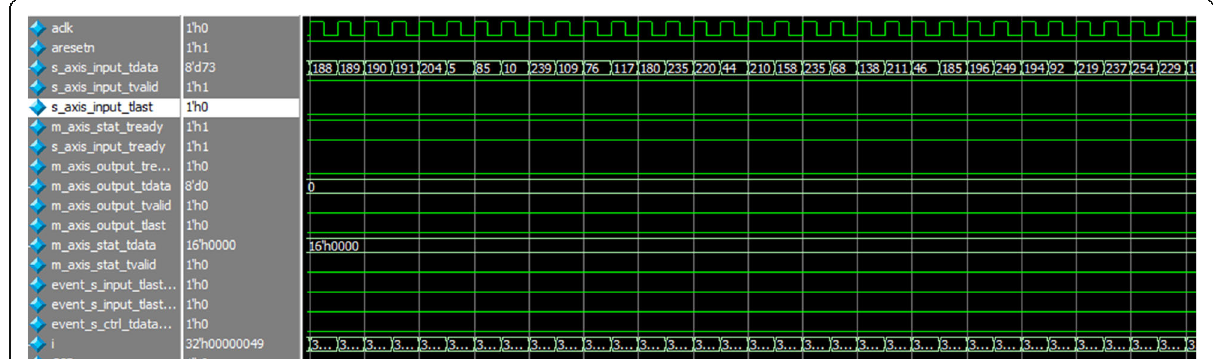
Fig. 12 The simulation diagram 2 of the RS decoder. The output data of the decoders. The output of RS encoding is used as the input of RS decoding data